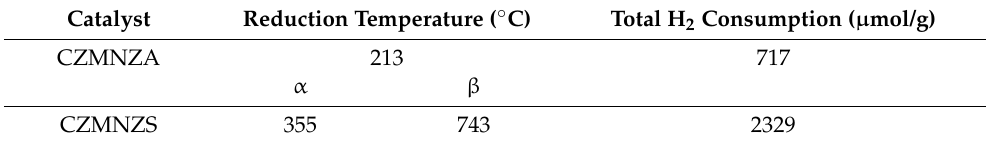
Table 4. H 2 -TPR data of CZMNZA and CZMNZS.